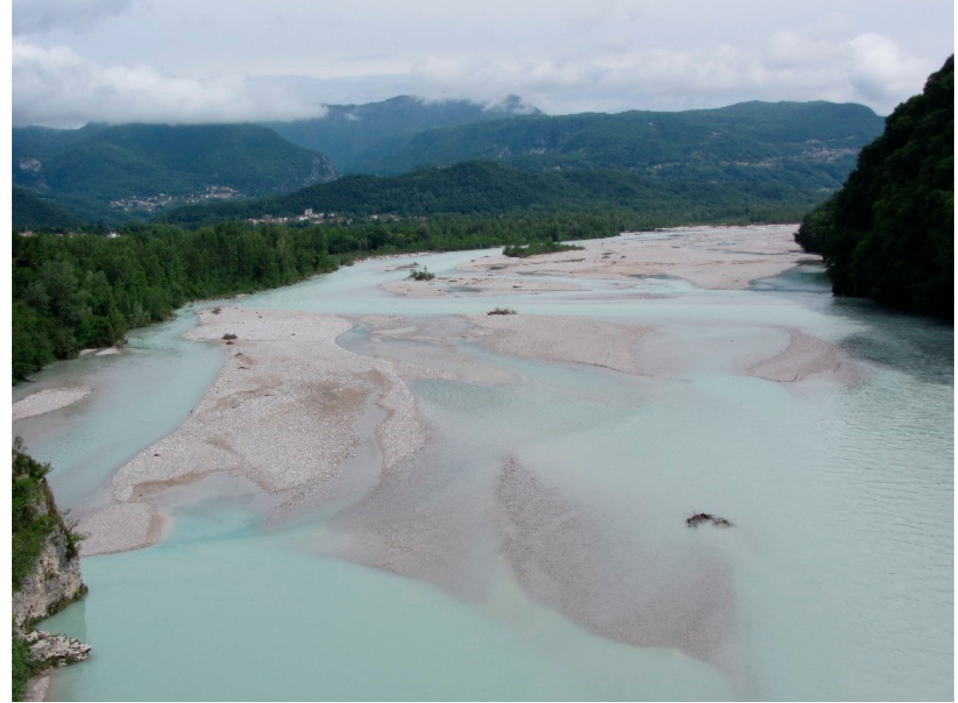
Figure 3. Tagliamento River, Italy. Multiple free bars have merged into large compound